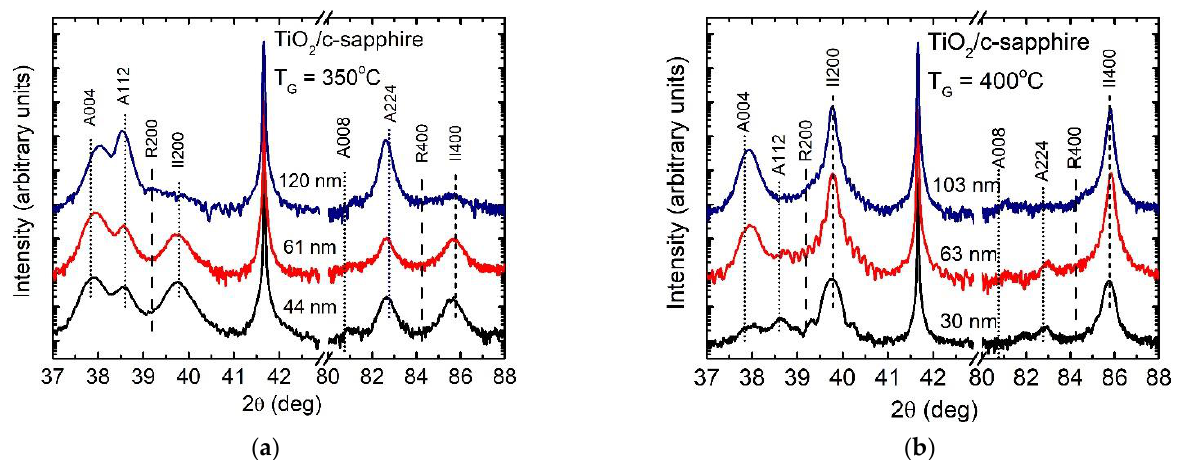
Figure 5. HRXRD patterns of TiO 2 films with different thicknesses grown on c-sapphire at ( a ) 350 °C and ( b ) 400 °C. Film thicknesses and Miller indices of anatase (A), rutile (R), TiO 2 -II (II), and sapphire (S) are shown with diffraction patterns. Vertical lines mark the database positions of anatase (PDF 84-1286), rutile (PDF 78-2485), and TiO 2 -II (PDF 01-076-6065) reflections.